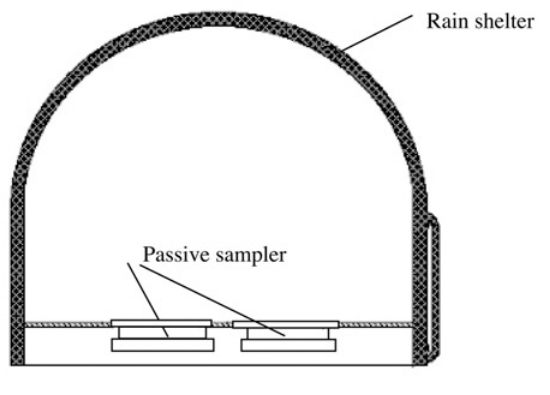
FIGURE 3. Personal monitor of the PASS H 2